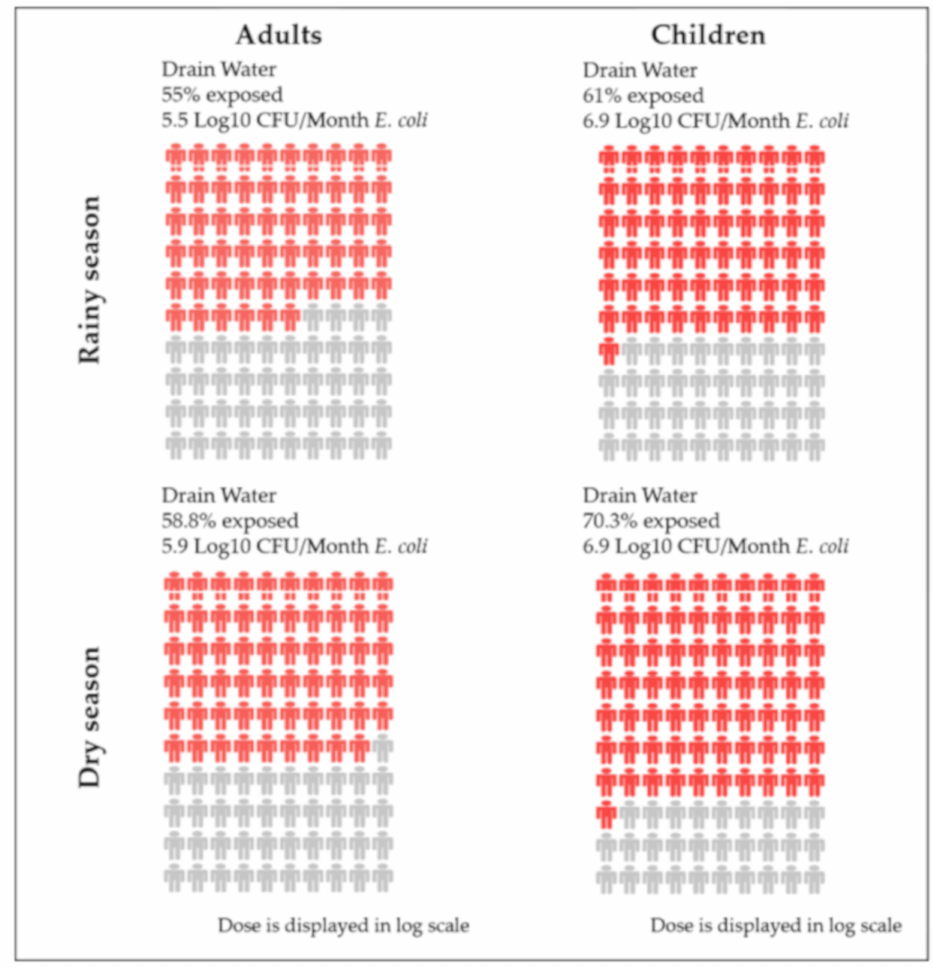
Figure 2. Risk profiles (people plots) for open drains for the rainy and dry seasons. Each red figure on the people plot represents one percent of the population for either an adult or a child that is exposed to faecal contamination in a pathway. The color change of red represents the magnitude of the dose of Escherichia coli ( E. coli ) ingested per month, with darker red representing a higher dose. The grey figures represents the population that is not exposed to faecal contamination in a